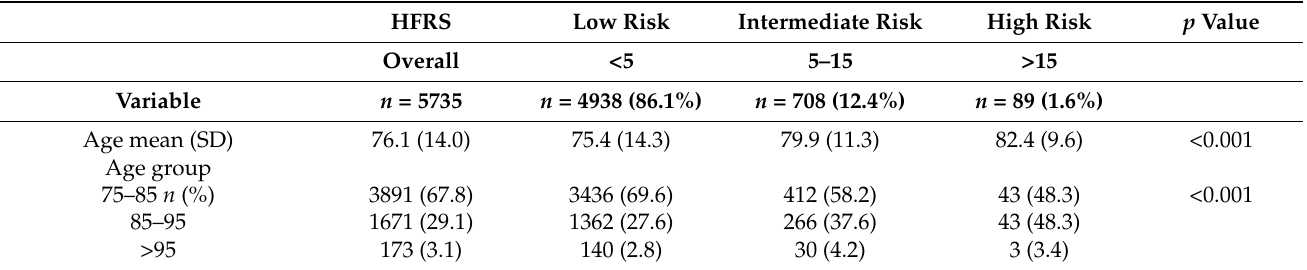
Table 1. Baseline characteristics of